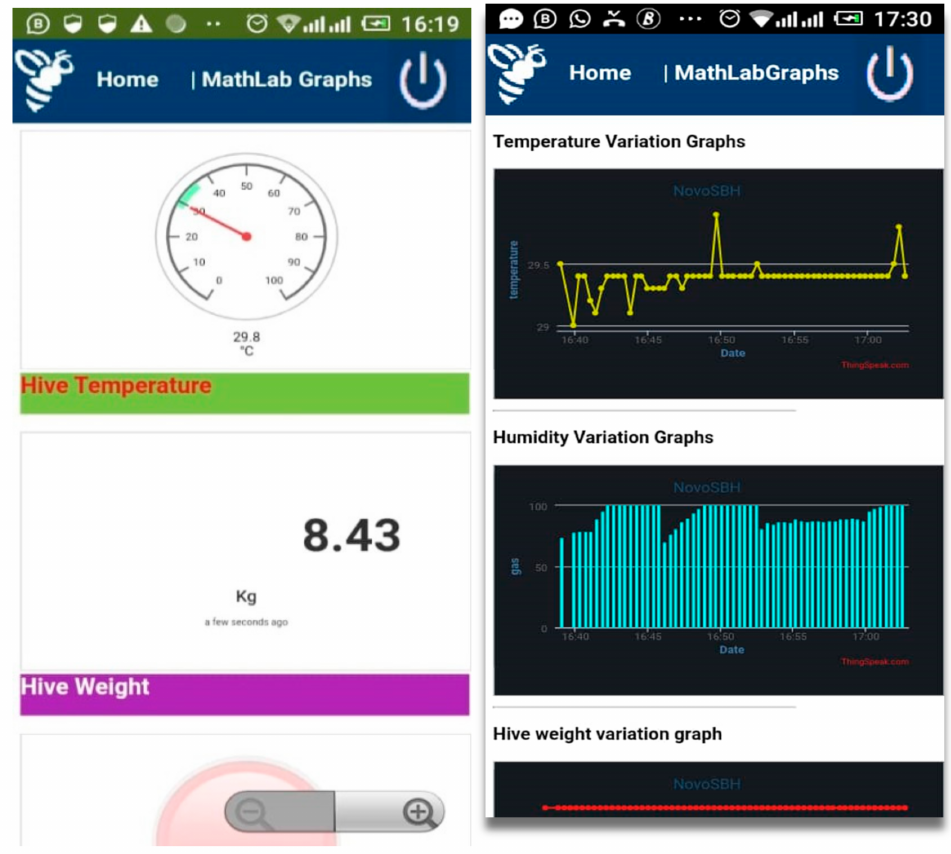
Figure 19. Different graphs of humidity, temperature, and weight.